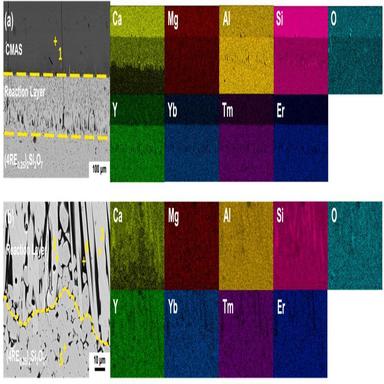
Cross-sectional SEM images and corresponding elemental mappings of (Y0,25Er0,25Tm0,25Yb0,25)2Si2O7 after CMAS corrosion at 1300 ◦C for 24 h under (a) low magnification and (b) high magnification.